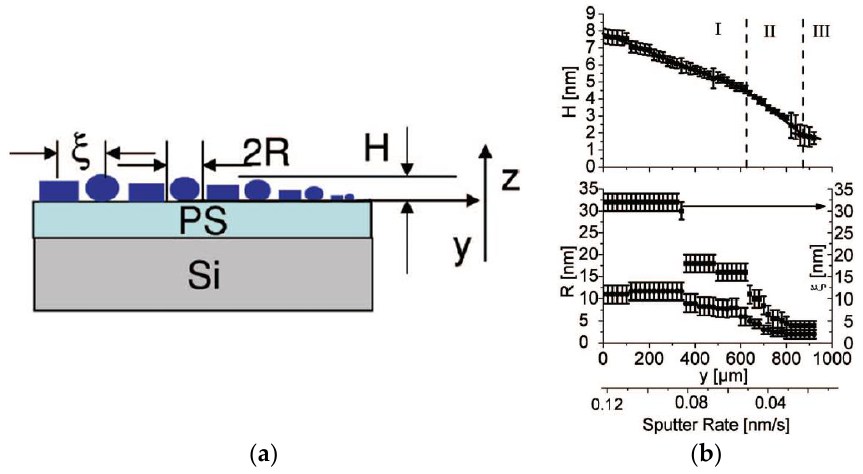
Figure 2. ( a ) Sketch of the nanostructure of the gradient sputter deposited Au clusters/polystyrene (PS) system. The sputter deposited Au clusters are depictured as mixture of spheroidal and cylindrical nano-objects. The gradient is in y direction. The clusters are on top of the PS film with height H , particle diameter 2 R and center-to-center distance ξ . ( b ) Radius R and distance ξ as a function of position y in the gradient. Clearly, three regimes are visible: I–coalesced Au layer, II–isolated nanoparticle layer, III–complete suppression of coalescence, only small particles prevail. Reproduced with the permission from [150]. Copyright AIP Publishing,